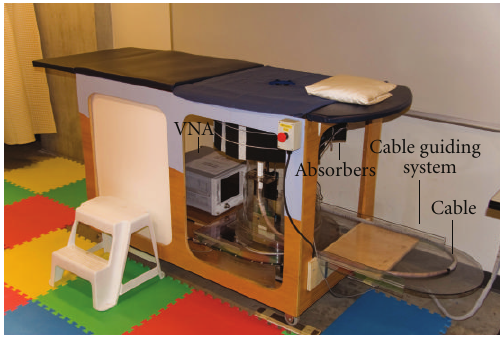
Figure 1: TSAR system used to scan volunteers.